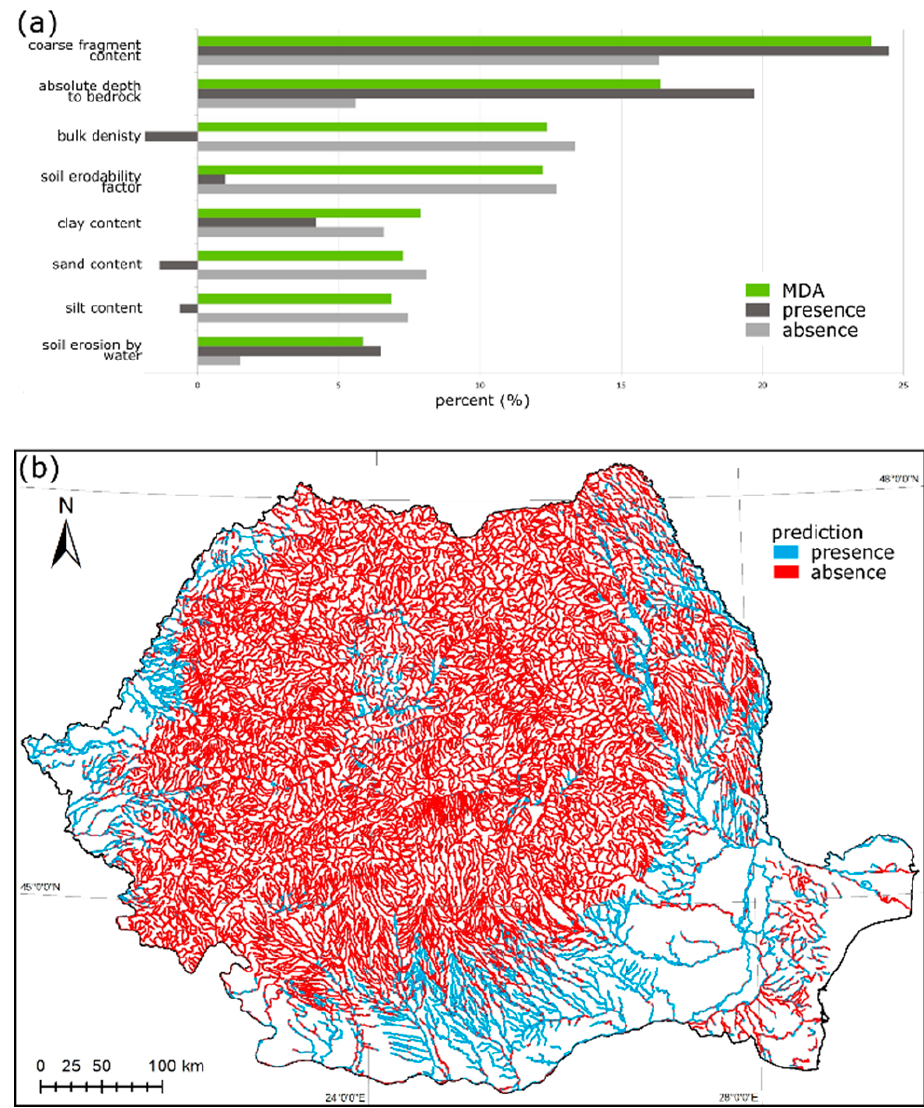
Figure 5. ( a ) Mean decrease in accuracy of soil-related factors for predicting Pontastacus leptodactylus species distribution. ( b ) Prediction map of P . leptodactylus species distribution based on soil-related factors.